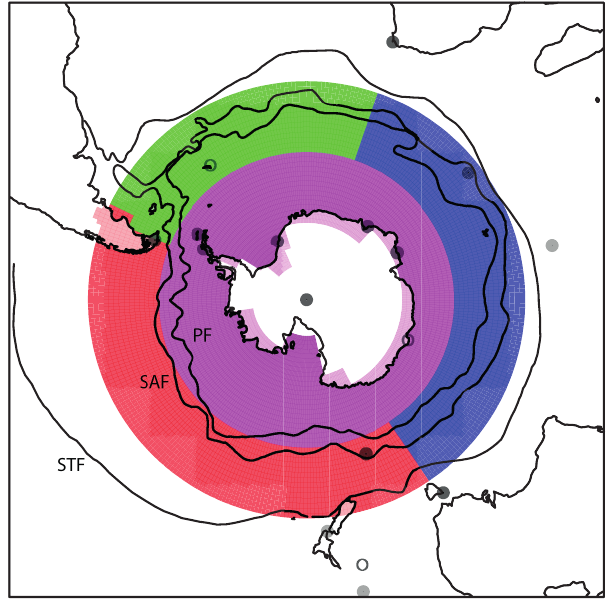
Fig. 1. Subregions of the Southern Ocean (44 to 75 ◦ S) used in this paper are the circular region 44–58 ◦ S (green, red and blue com- bined) and the major ocean basins (Pacific, Indian and Atlantic) in this band, and the circumpolar region from 58–75 ◦ S (purple). Overlain is the network of atmospheric observations of CO 2 . The colour of the dot indicates how many inversions used data from that location (dark grey: all or almost all inversions, light grey: around half the inversions, white: one or two inversions). We note that the temporal period over which the data was collected is not the same in all the stations. Overlain on these figures, from north to south are the mean positions of the major fronts subtropical front (STF), Subantarctic front (SAF) and the Polar Front (PF) following Orsi et al. (1995)